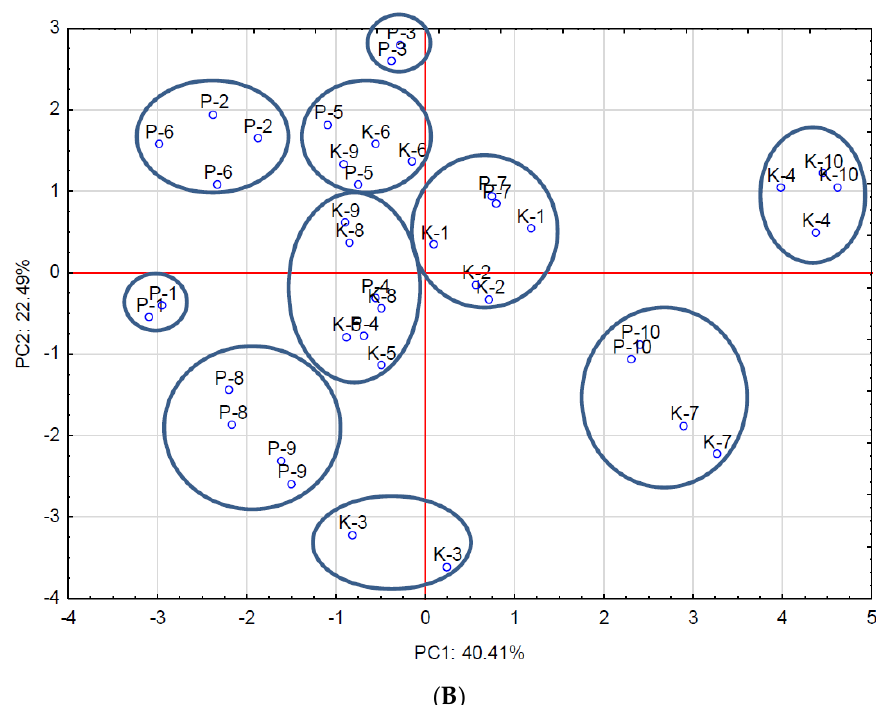
Figure 1. Biplot based on first two principal component axes for chemical composition of buckwheat sprouts ( A ) and distribution of two cultivars on buckwheat sprouts based on the first two components obtained from principal component analysis ( B ). K denotes cultivar Kora, P denotes cultivar. Panda and number from 1 to 10 denote buckwheat seed treatments precisely described in Materials and Methods.